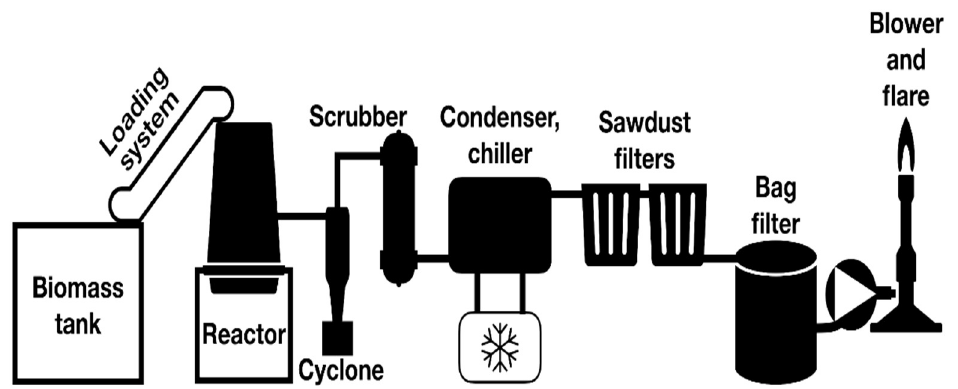
Figure 2. Ankur Scientific filtration system (adapted from [40]).